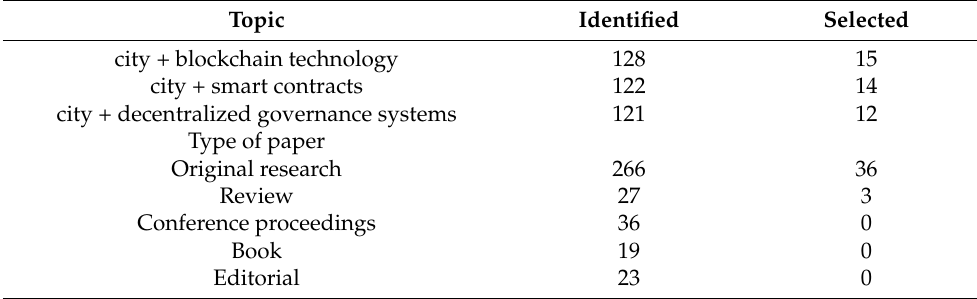
Table 1. Topics and types of scientific products identified and selected. Topic